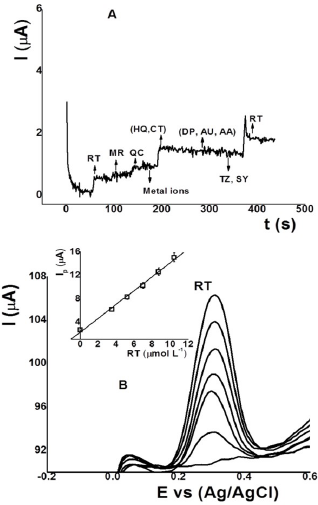
Figure 7. ( A ) Amperograms for RT with morin (MR), quercetin (QC), metal ions, hydroquinone (HQ), catechol (CT), dopamine (DP), ascorbic acid (AA), uric acid (UA), tartrazine (TZ), sunset yellow (SY) and ( B ) adsorptive voltammograms and calibration curves (inset) of sample 1 * (Table 2). Using the IL‐CS/SPC electrode under the same conditions as Figure 6.